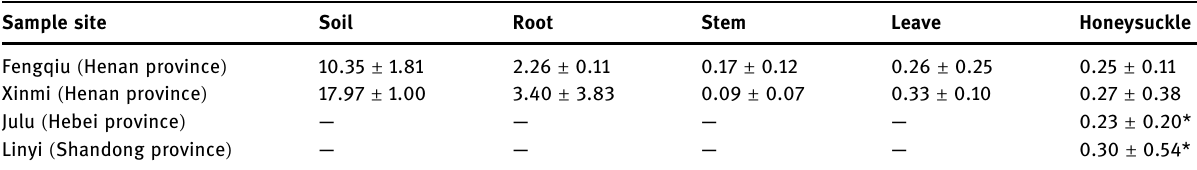
Table 2: ICP - MS determination of the total As content in samples ( mg/kg ) ( n = 3 )